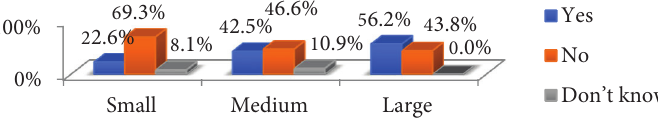
Figure 3. Use of personnel controlling in the enterprises